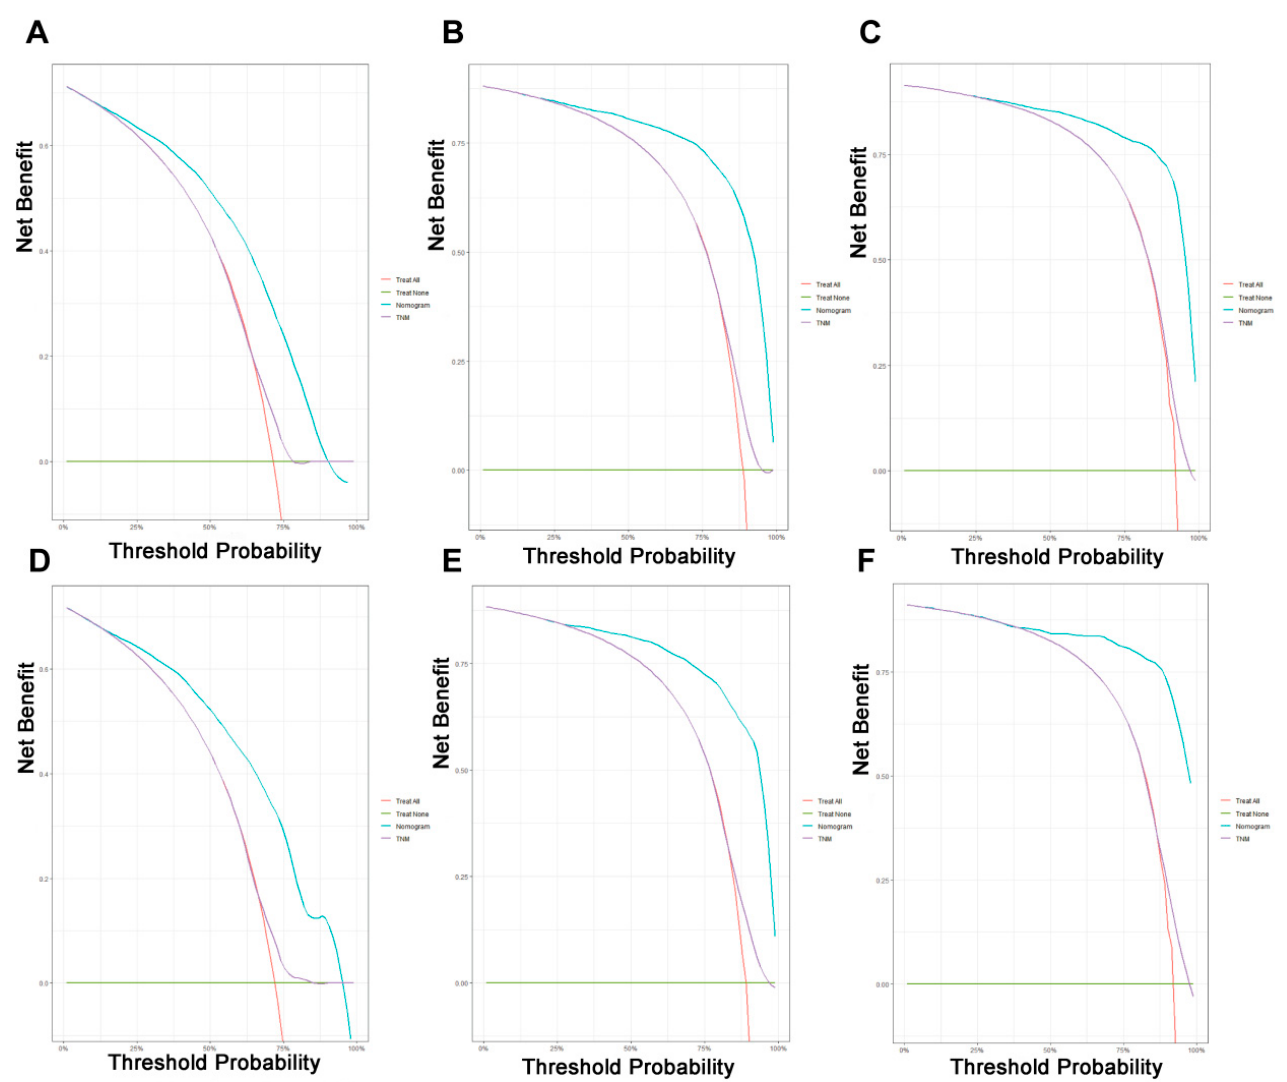
Figure 6. Decision curve analysis of the prognostic nomogram and TNM staging system for pre- dicting the overall survival in patients with liver metastases from pancreatic cancer. ( A – C ) Survival benefits at 1, 3, and 5 years in the training cohort. ( D – F ) Survival benefits at 1, 3, and 5 years in the validation cohort.